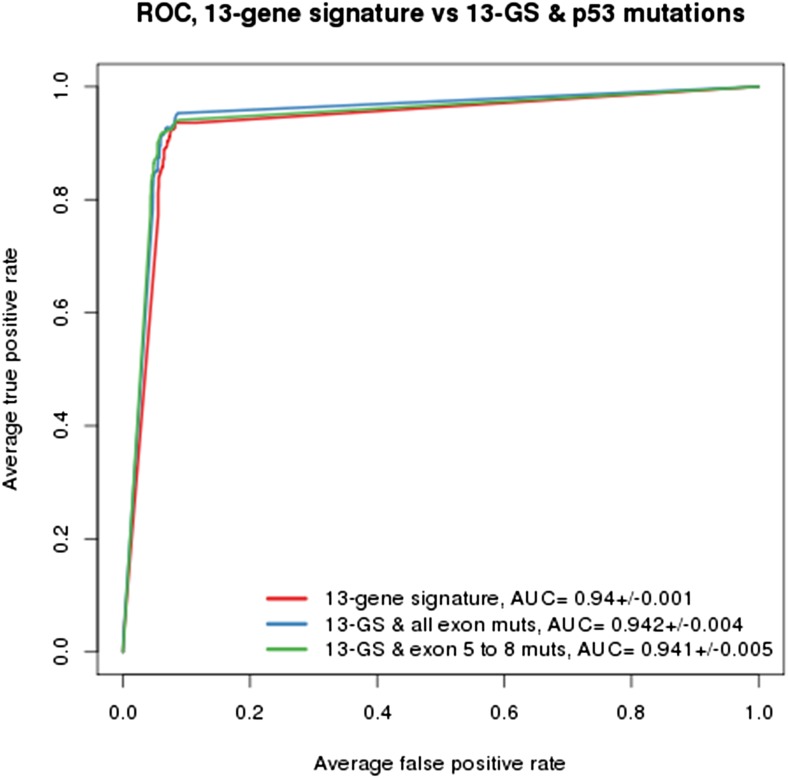
DOI:
http://dx.doi.org/10.7554/eLife.06498.019